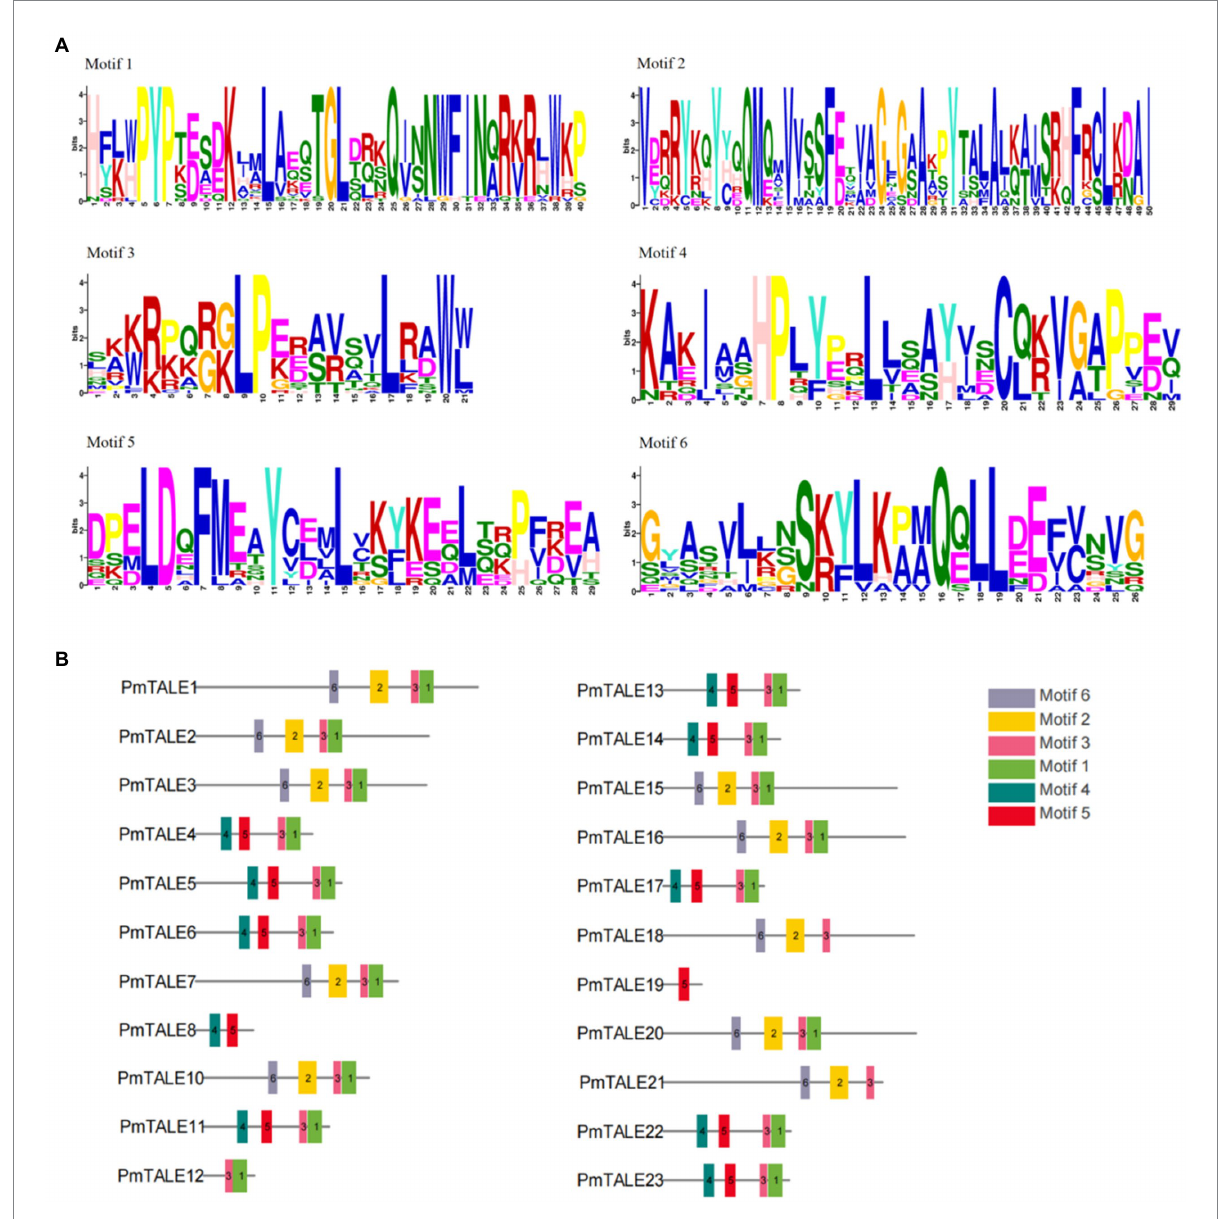
FIGURE 4 Motif analysis of the protein sequence of the Prunus mume TALE gene family, (A) shows the sequences of the six kinds of motifs; (B) reflects the distribution of the six kinds of motifs on the P. mume TALE protein